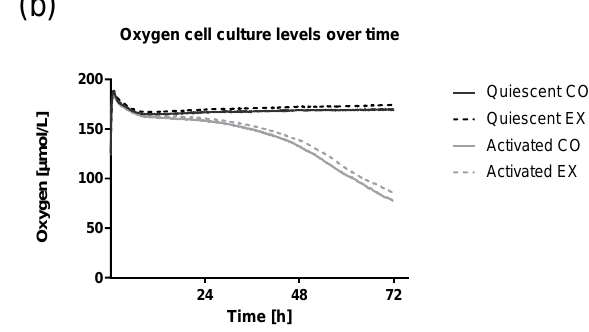
Figure 5. Oxygen cell culture levels of culture medium, non-activated quiescent T cells, and activated T cells over time. Human CD4+ T cells from cohort 1 were activated supplemented by serum before exercise (CO) or after exercise (EX) and activated with anti-CD3/anti-CD28. Oxygen concentration during 72 h of cell culture measured by PreSens oxygen reader (SDR v4, PreSens Precision Sensing GmbH, Regensburg, Germany) is shown by the mean of n = 5. CO: control condition, EX: exercise condition. Mean oxygen levels of the culture medium including serum before or after exercise (Medium) overlap ( a ), while mean oxygen levels of quiescent and activated cells are higher when serum after exercise was supplemented ( b ).